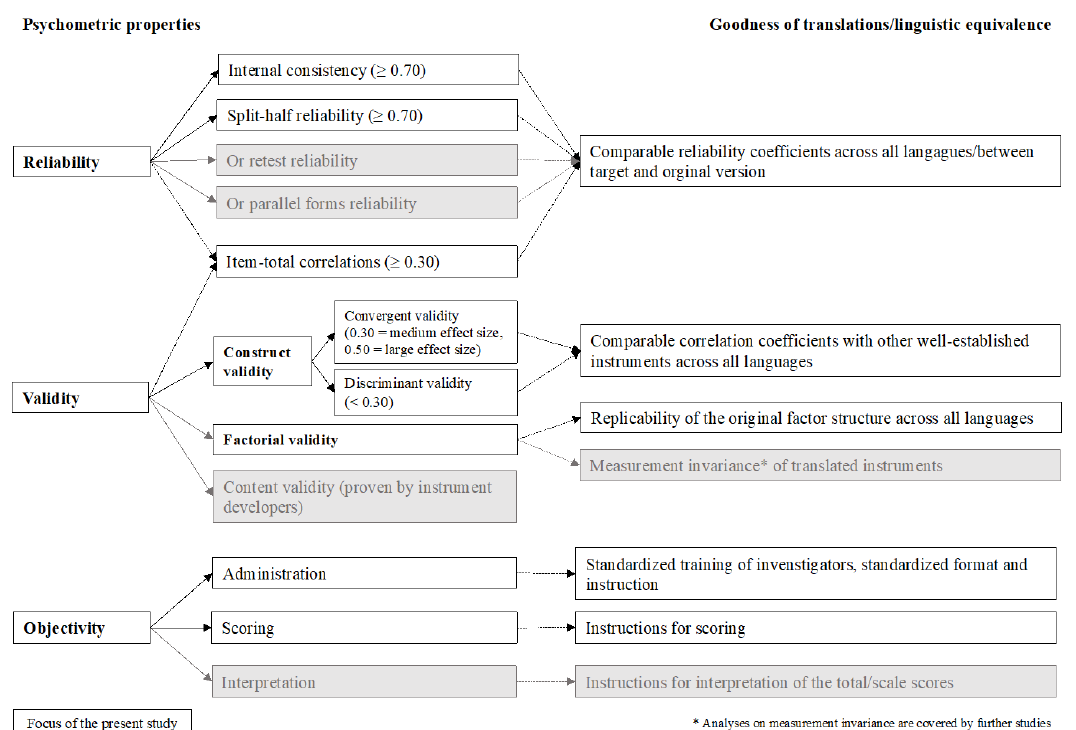
Figure 1. Criteria of classical test theoretical psychometric analyses and their application in this study. The white boxes indicate analyses performed in this study; the grey boxes describe psychometric properties investigated either during instrument development (i.e., content validity), or alternative methods of retest reliability or parallel form reliability, or analyses deferred to further studies (i.e., measurement invariance and interpretation).